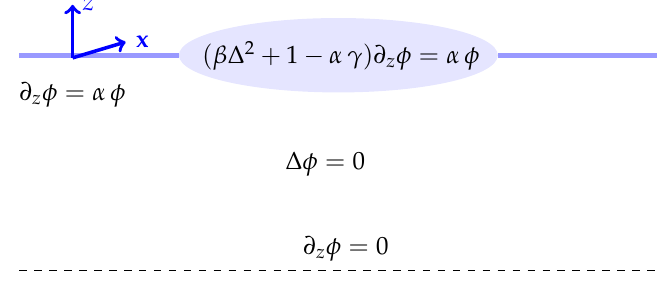
Figure 1. Frequency-domain equations for a floating circular